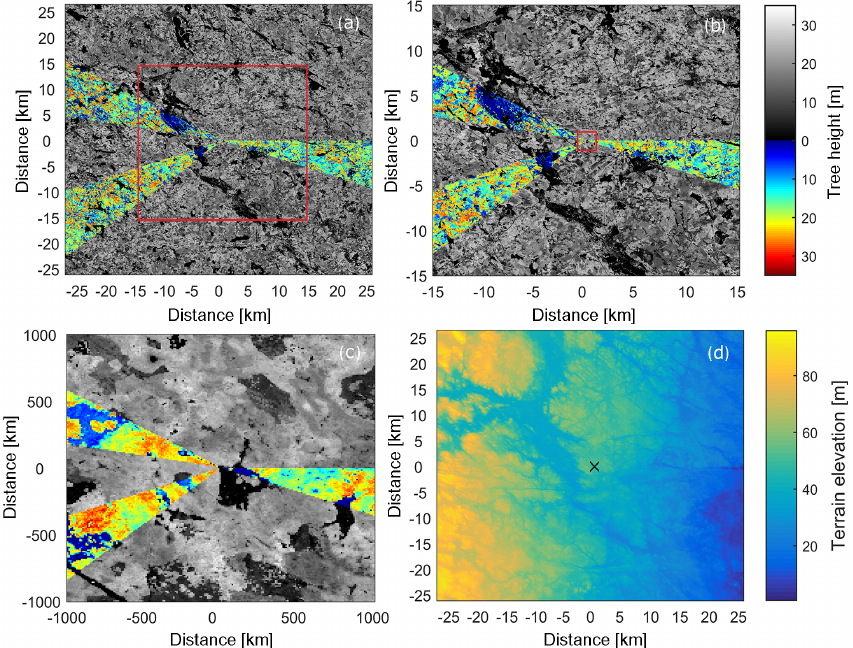
Figure 1. (a–c) Forest cover of the Ryningsnäs site with increasing magnification factors. The contour maps are in greyscale and the colour scales illustrate the tree height distribution, both inside and outside the selected area. (d) A topographic map of the Ryningsnäs area.